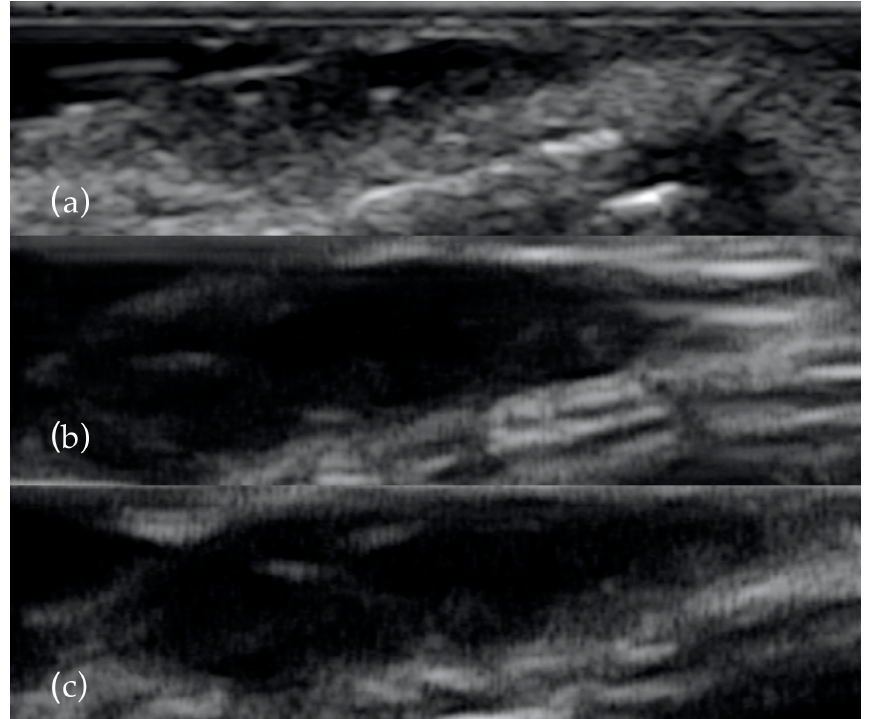
Figure 1. The same BCC examined with 13 MHz ( a ), 20 MHz ( b ) and 40 MHz ( c ). As the frequency increases, the presence of the two hyperechoyc spots is clearer.